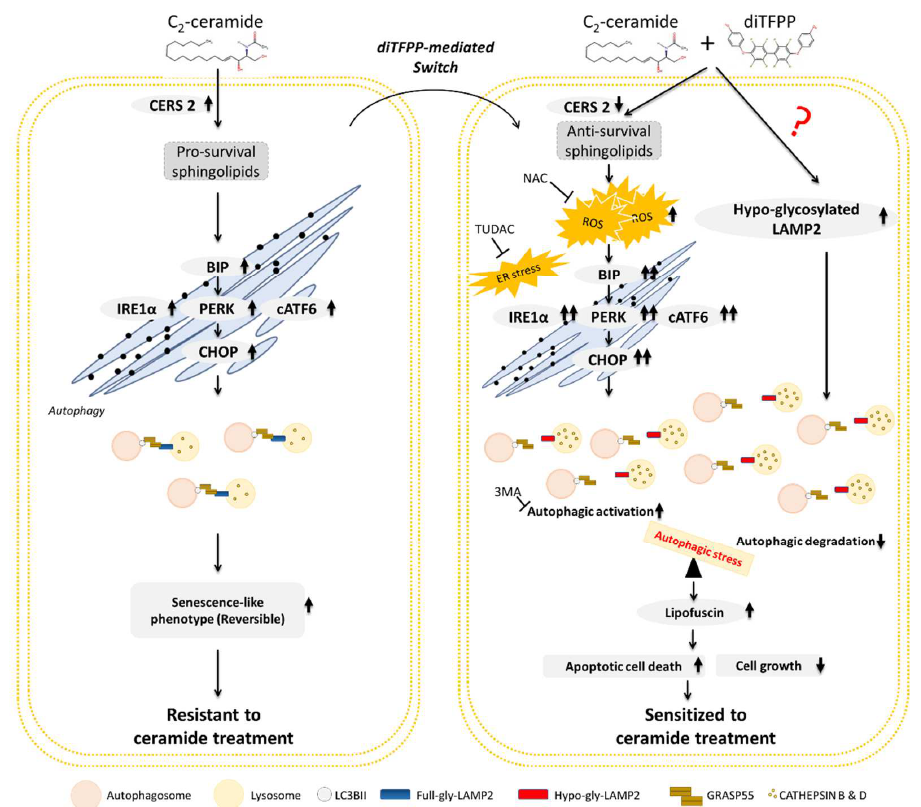
Figure 7. Proposed role of diTFPP in C 2 -ceramide-induced death and growth arrest in HCC cells. The metabolism of endogenous sphingolipids favors the conversion of C 2 -ceramide to a prosurvival sphingolipid, inducing mild ER stress and autophagy. Reversible SLP may attenuate C 2 -ceramide- induced anti-HCC effects, such as proliferation inhibition and apoptosis induction, rendering HCC cells resistant to C 2 -ceramide treatment. However, diTFPP promotes the conversion of prosurvival sphingolipids to proapoptotic sphingolipids and increases C 2 -ceramide-induced cellular stresses, including oxidative stress, ER stress, and autophagic stress. In contrast, C 2 -ceramide/diTFPP cotreat- ment also decreases the full glycosylation of LAMP2, a hallmark of mature lysosomes, impairing autophagosome–lysosome fusion and contributing to the severity of autophagic stress. Thus, the abovementioned stress sensitizes HCC cells to C 2 -ceramide-induced apoptosis. Full-gly LAMP2: fully glycosylated LAMP2; hypo-gly LAMP2: hypoglycosylated LAMP2.